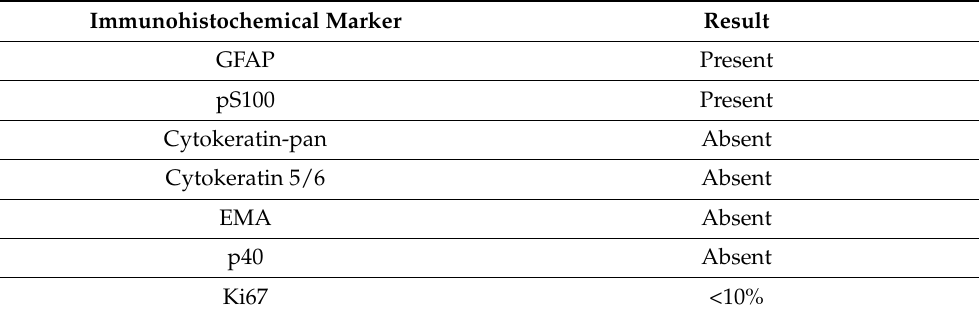
Table 1. Immunohistochemical analysis on the muscular MPE metastasis. Immunohistochemical markers analyzed in the patient. (EMA, epithelial membrane antigen; GFAP, glial fibrillary acid protein; p, protein).